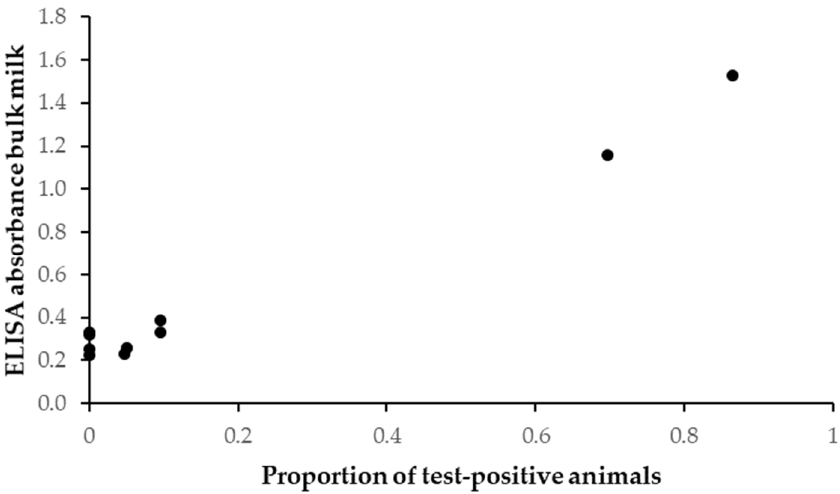
Figure 4. Absorbance value of bulk milk analysed in CLA ELISA compared to proportion of test- positive goats (serum) in the herd in 10 herds and 213 lactating goats included in the study to esti- mate the occurrence of CAE and CLA (Sweden, 2018).